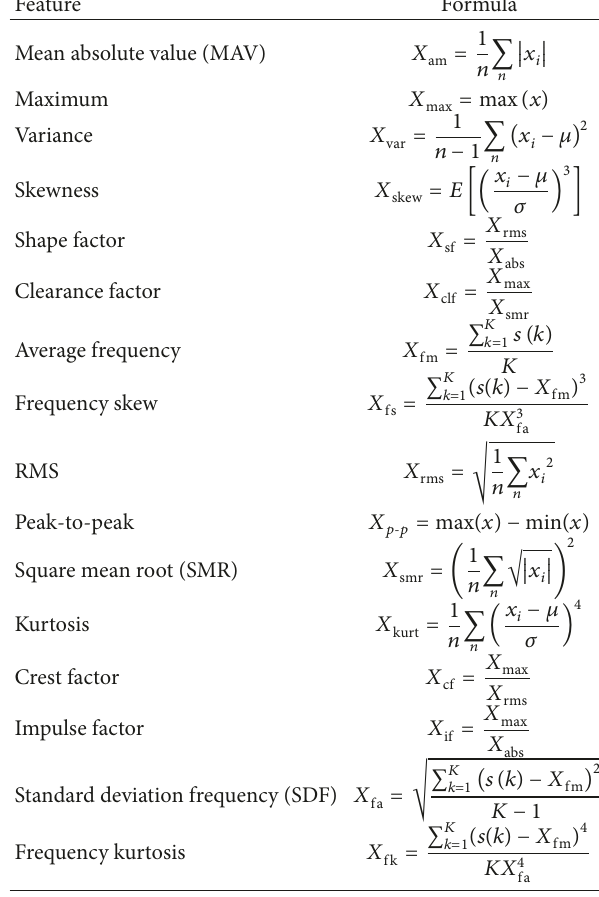
Table 1: Features and corresponding